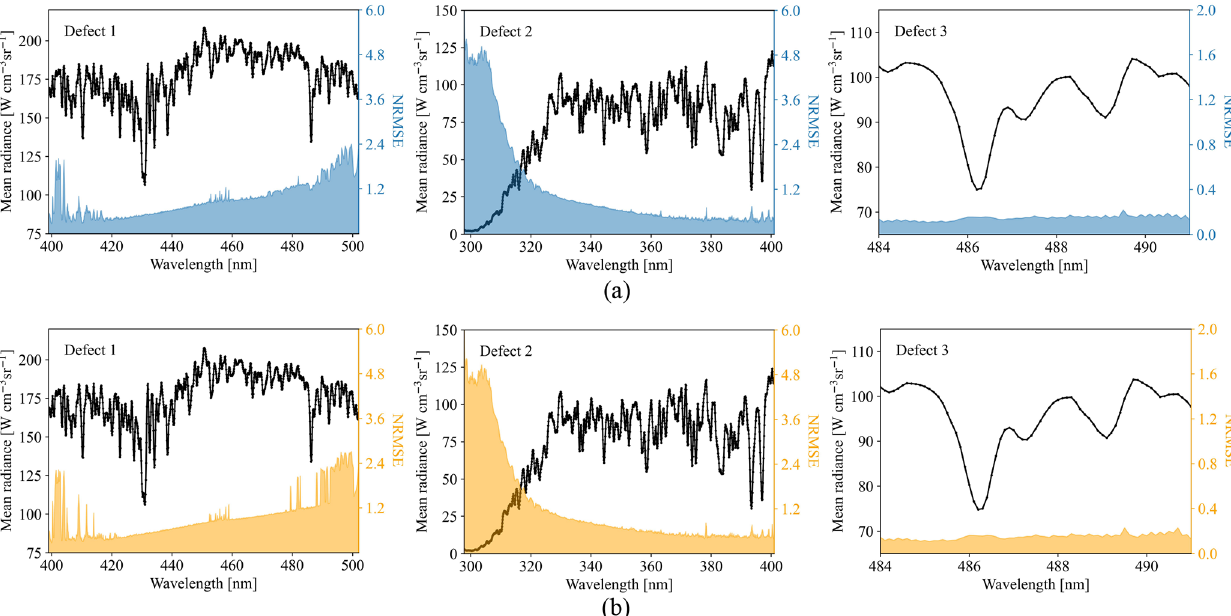
Figure 6. Output radiances for Defect 1–3 with the average and NRMSE for (a) training and (b) test datasets measured in March 2021. The unit of NRMSE is